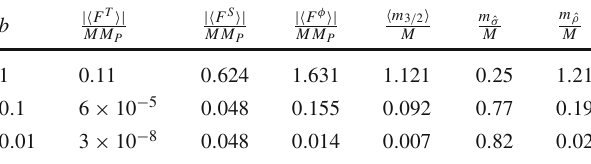
Table 6 The SUSY breaking VEVs of the auxiliary F -fields, the grav- itino mass m 3 / 2 , and the masses of ˆ σ and ˆ ρ for different values of the parameter b . The values of other parameters can be found in Table